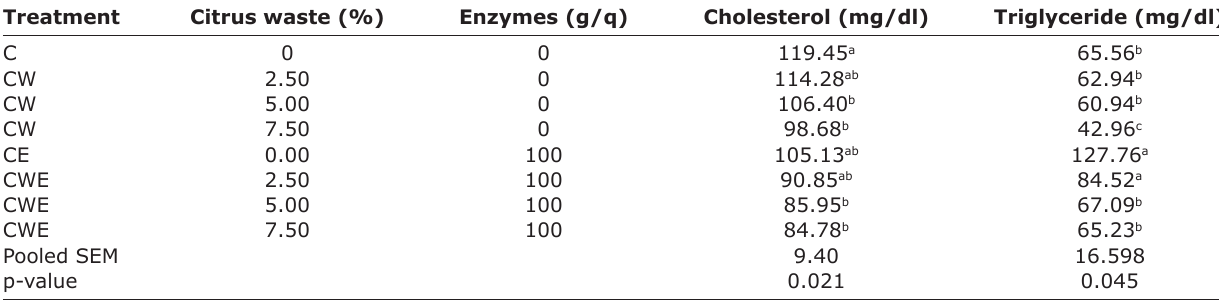
Table-10: Effect of citrus waste×enzyme on the lipid profile of blood in broiler.